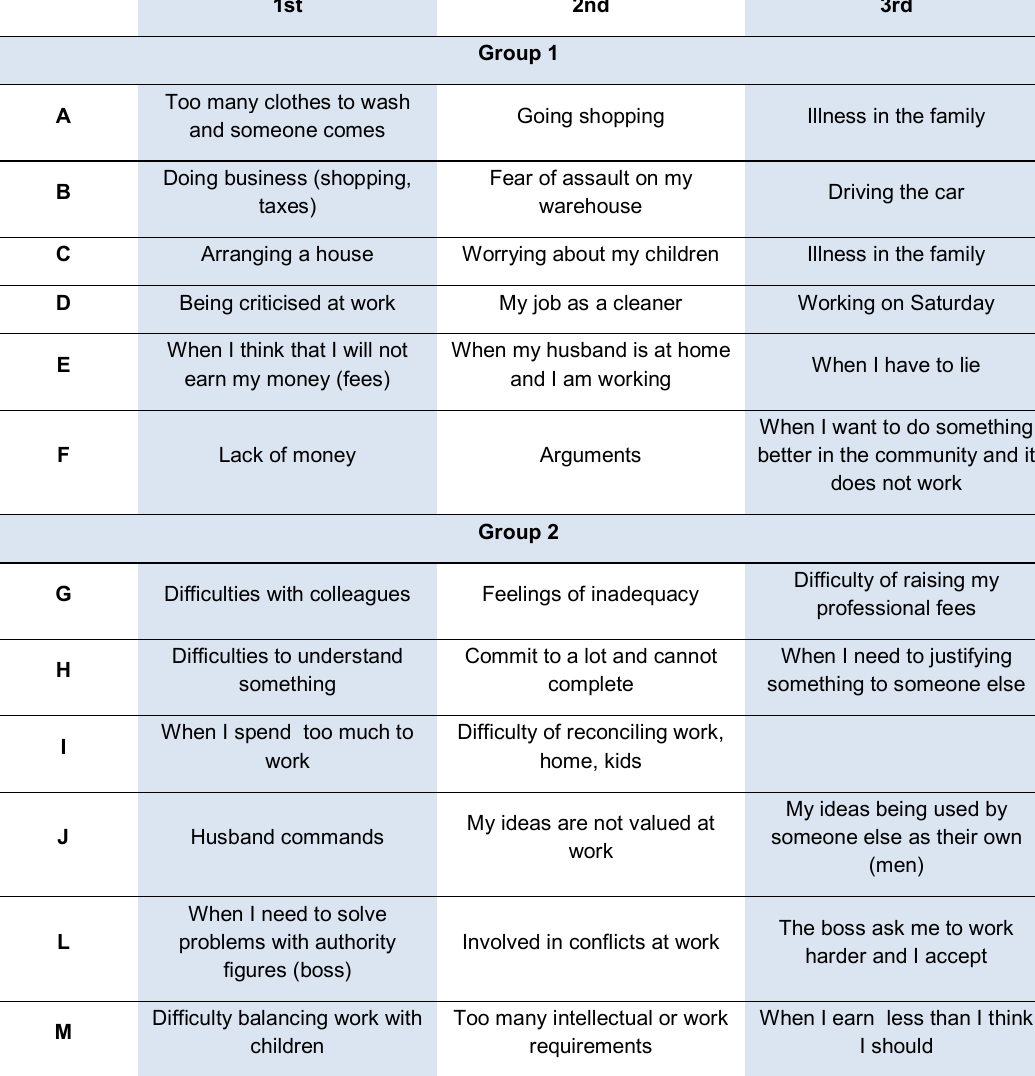
Table 2: Summary of Oppressive